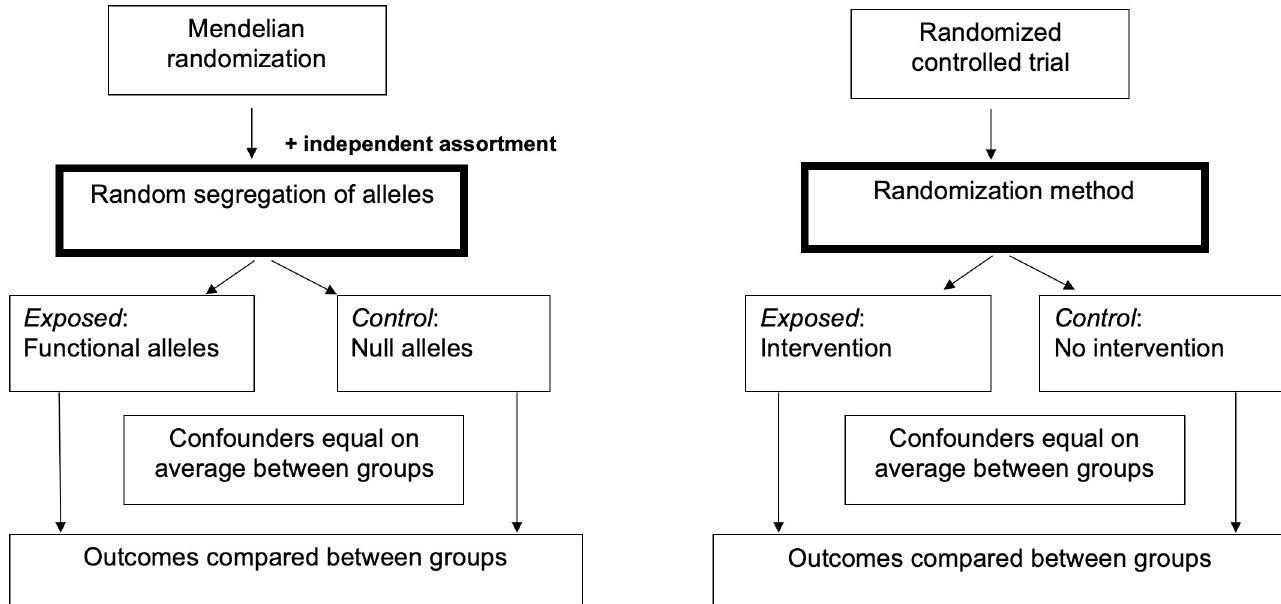
Fig 1. Similarities between the MR study design and a randomized controlled trial. MR, mendelian randomization.